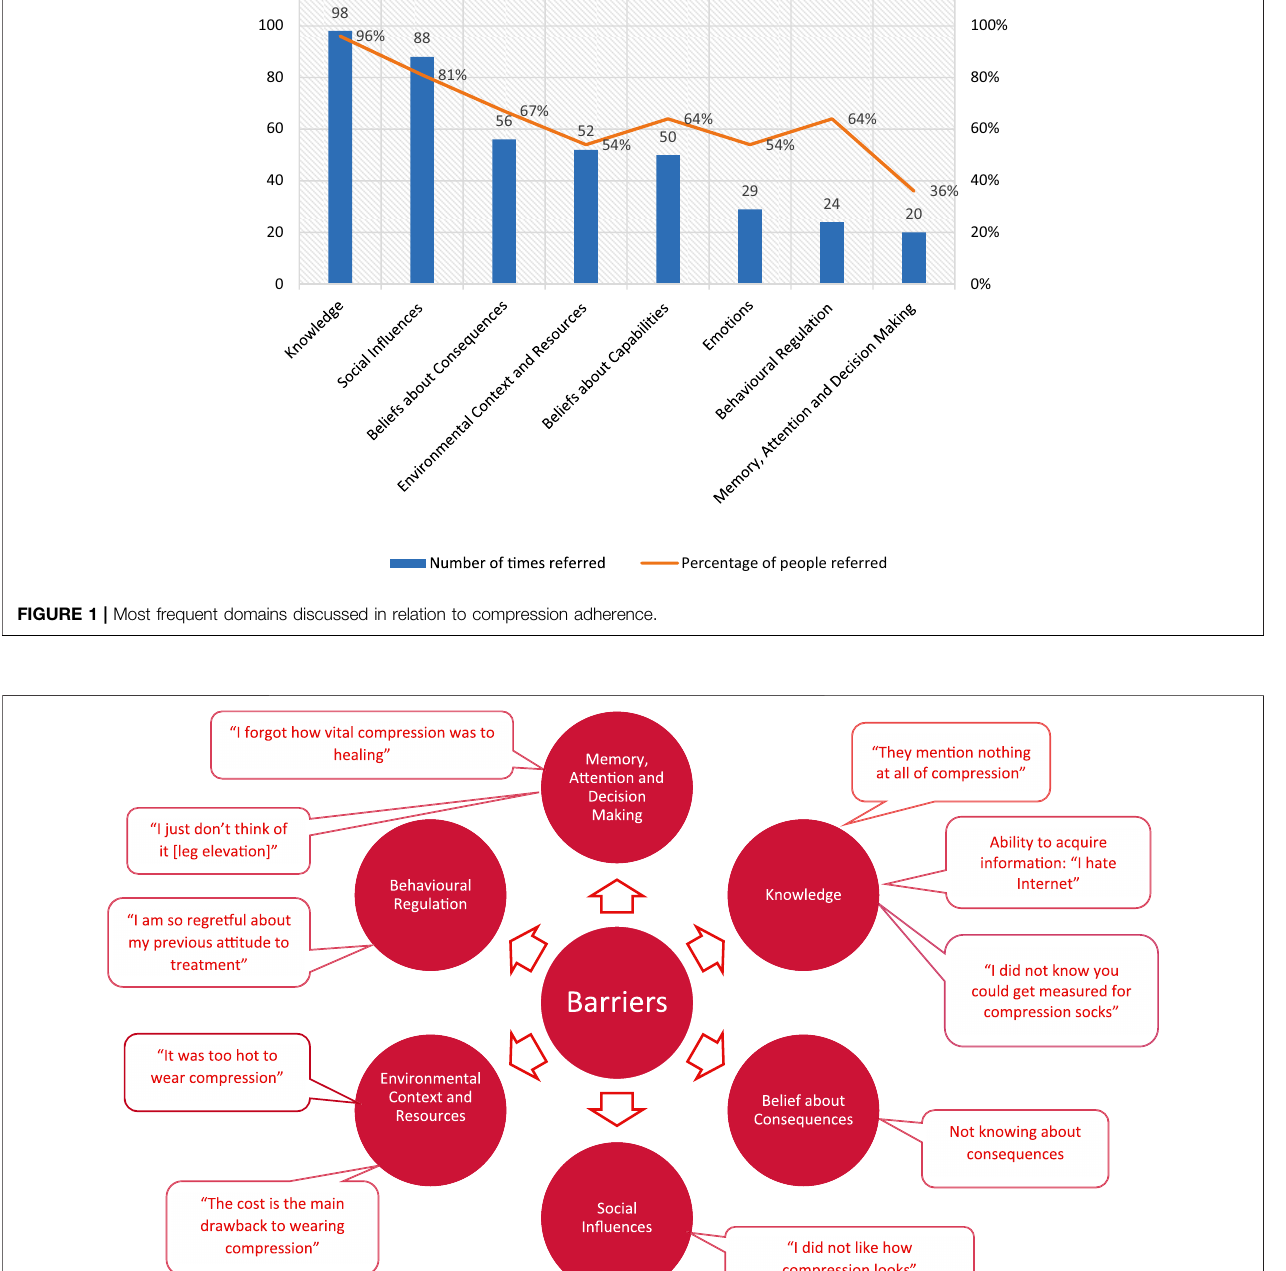
Frontiers in Pharmacology |